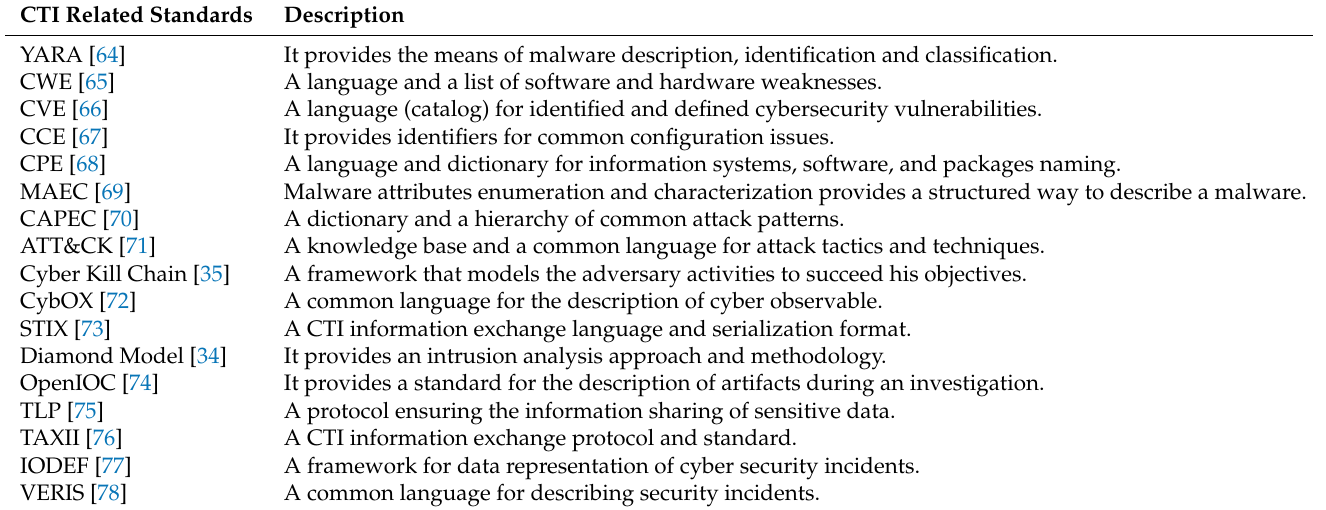
Table 1. CTI Related